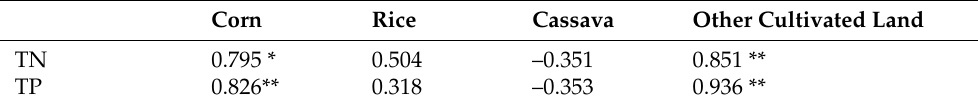
Table 5. Pearson correlation analysis between crop changes and TN/TP load. Corn Rice